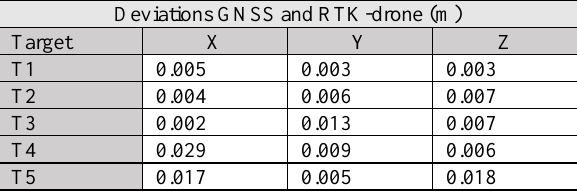
Table 1. Deviations between the GNSS measurements and the RTK-drone measurements.